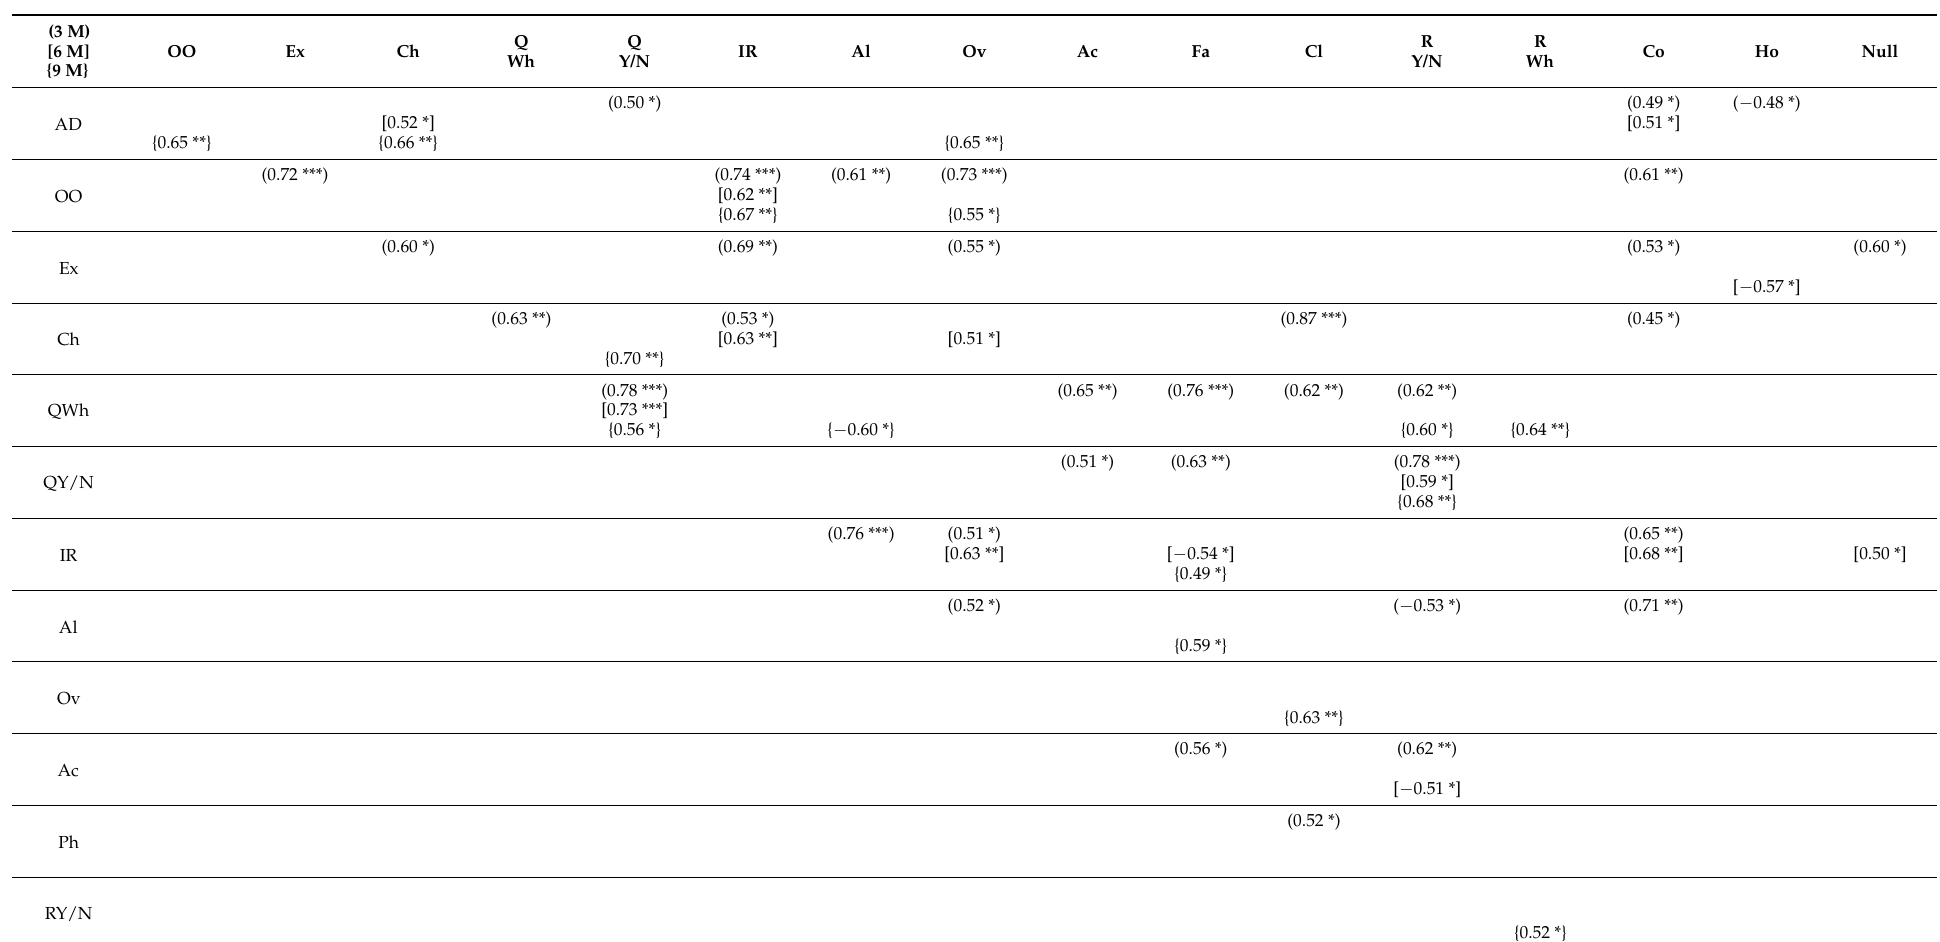
Table 3. Significant correlations for alpha 0.05 between the variables of Pra.Ti.D. at (3), [6] and {9} months (N =